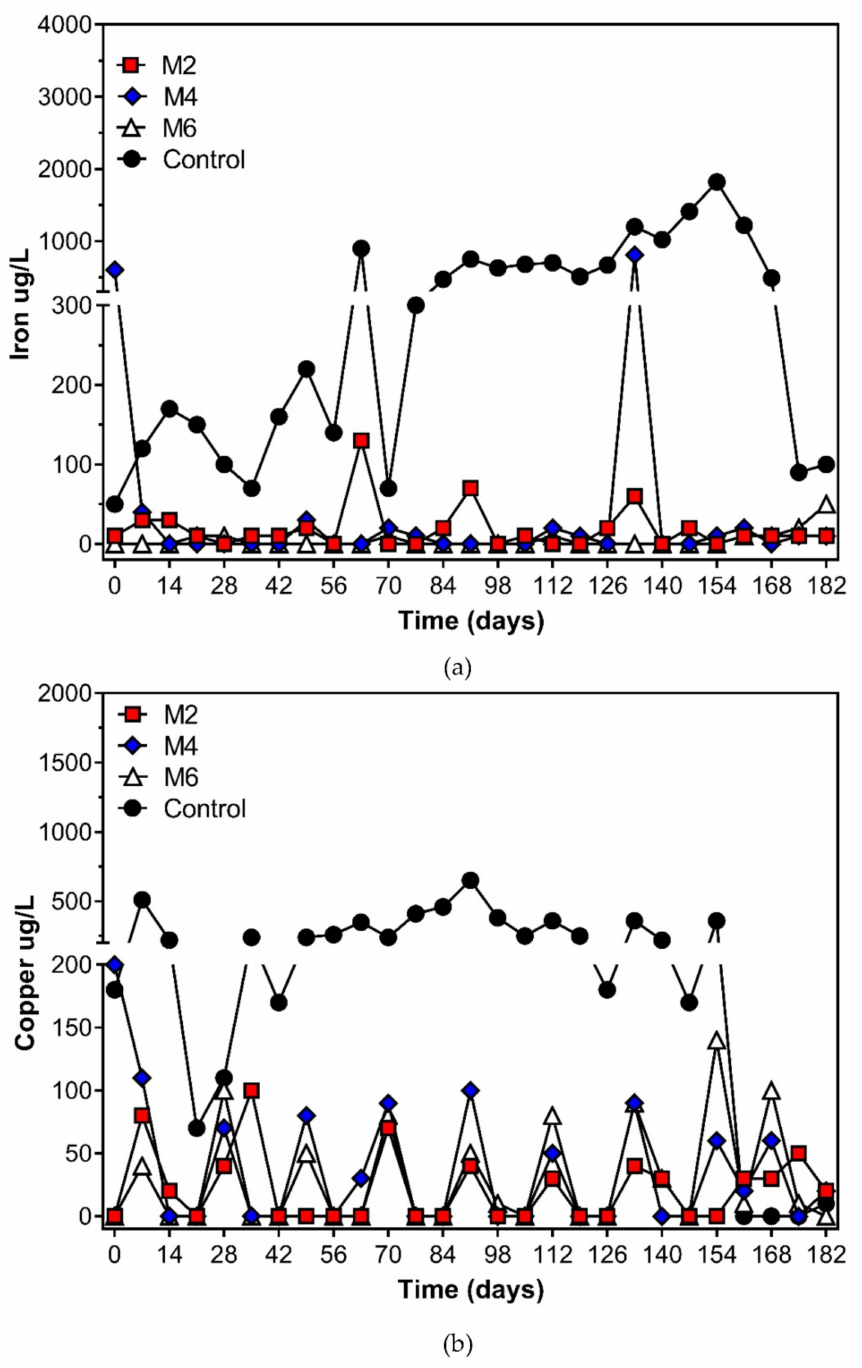
Figure 5. Dissolved iron ( a ) and dissolved copper ( b ) release over time in the humidity cells tests for paste-tailing